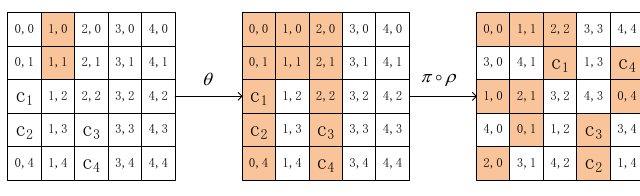
Figure 6: Diffusion of the 32-bit Keys in A [1 , 0], A [1 , 1] and 32-dimension Cube